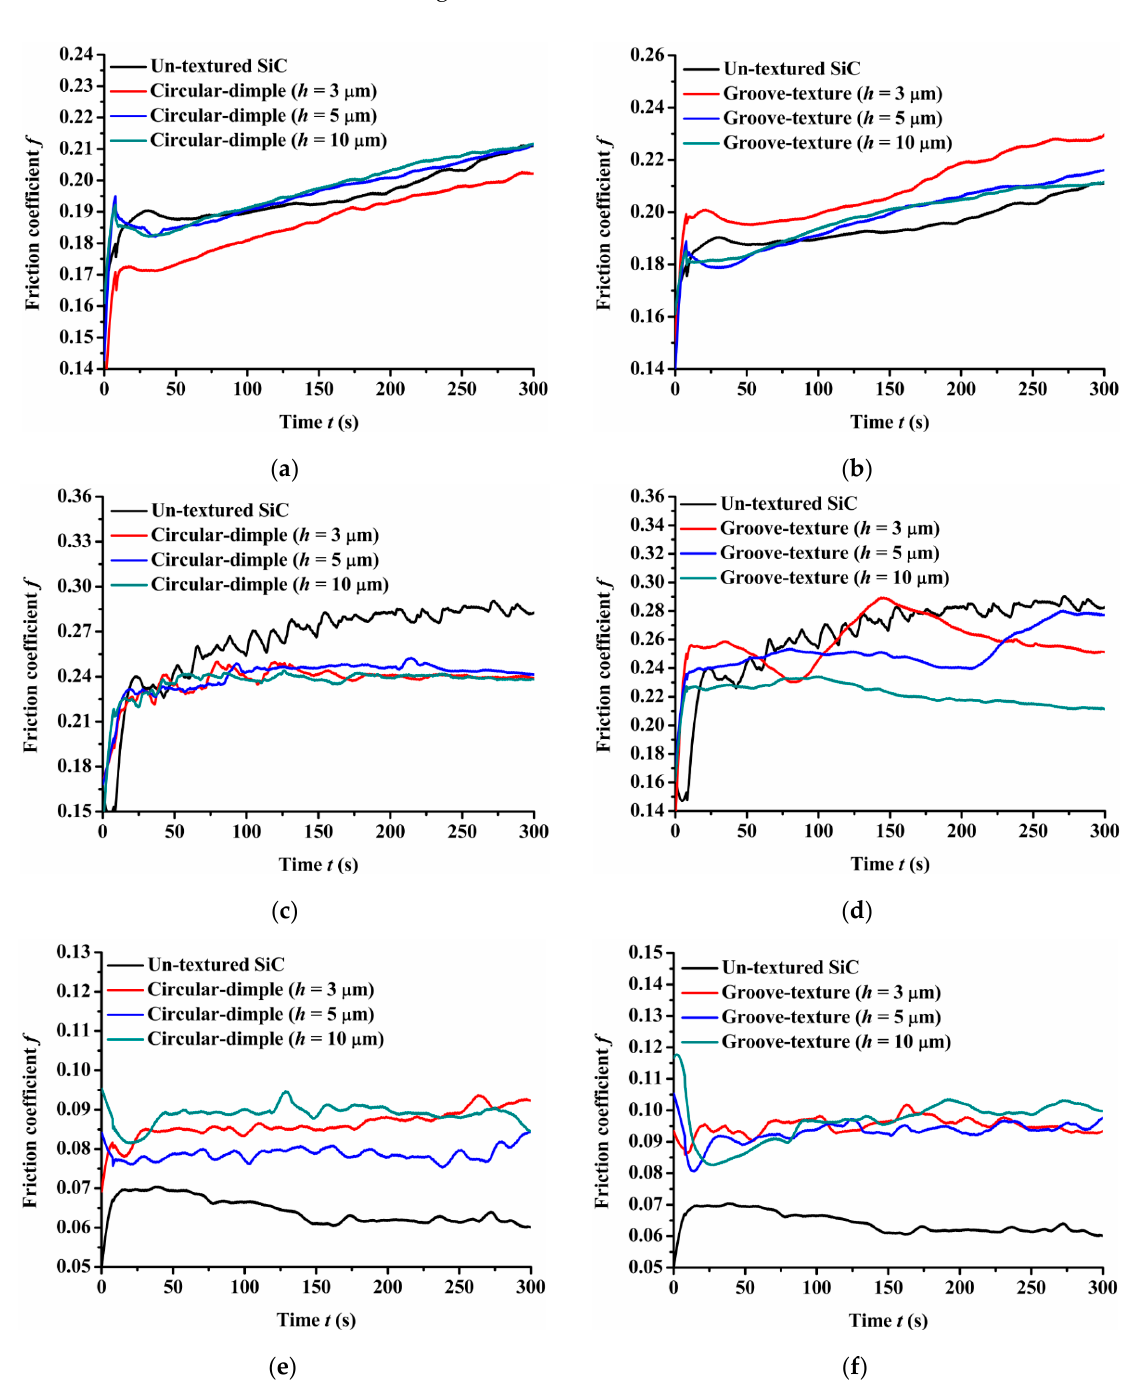
Figure 6. Friction performance of textured SiC under water-lubricated conditions with load of 75 N: ( a ) circular-dimple- textured SiC–steel ball, ( b ) groove-textured SiC–steel ball, ( c ) circular-dimple-textured SiC–Si 3 N 4 ball, ( d ) groove-textured SiC–Si 3 N 4 ball, ( e ) circular-dimple-textured SiC–PTFE ball, and ( f ) groove-textured SiC–PTFE ball.